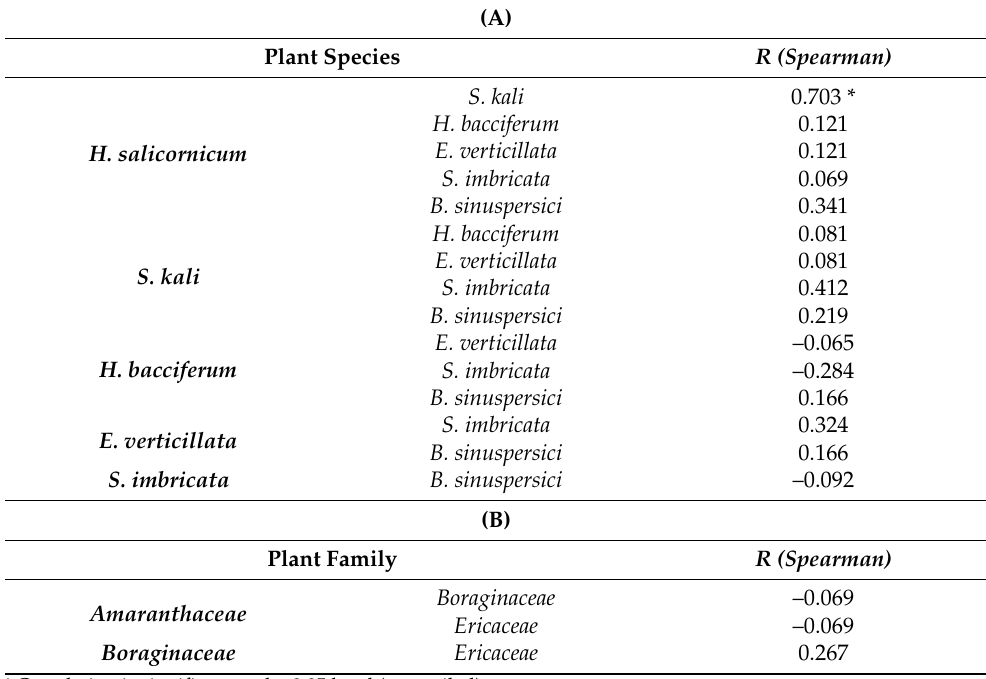
Table 3. Summarized table of Spearman’s correlation showing: ( A ). Correlated pairs of the six plant hosts in relation to EF community structure. ( B ). Correlated pairs of the three plant families in relation to EF community